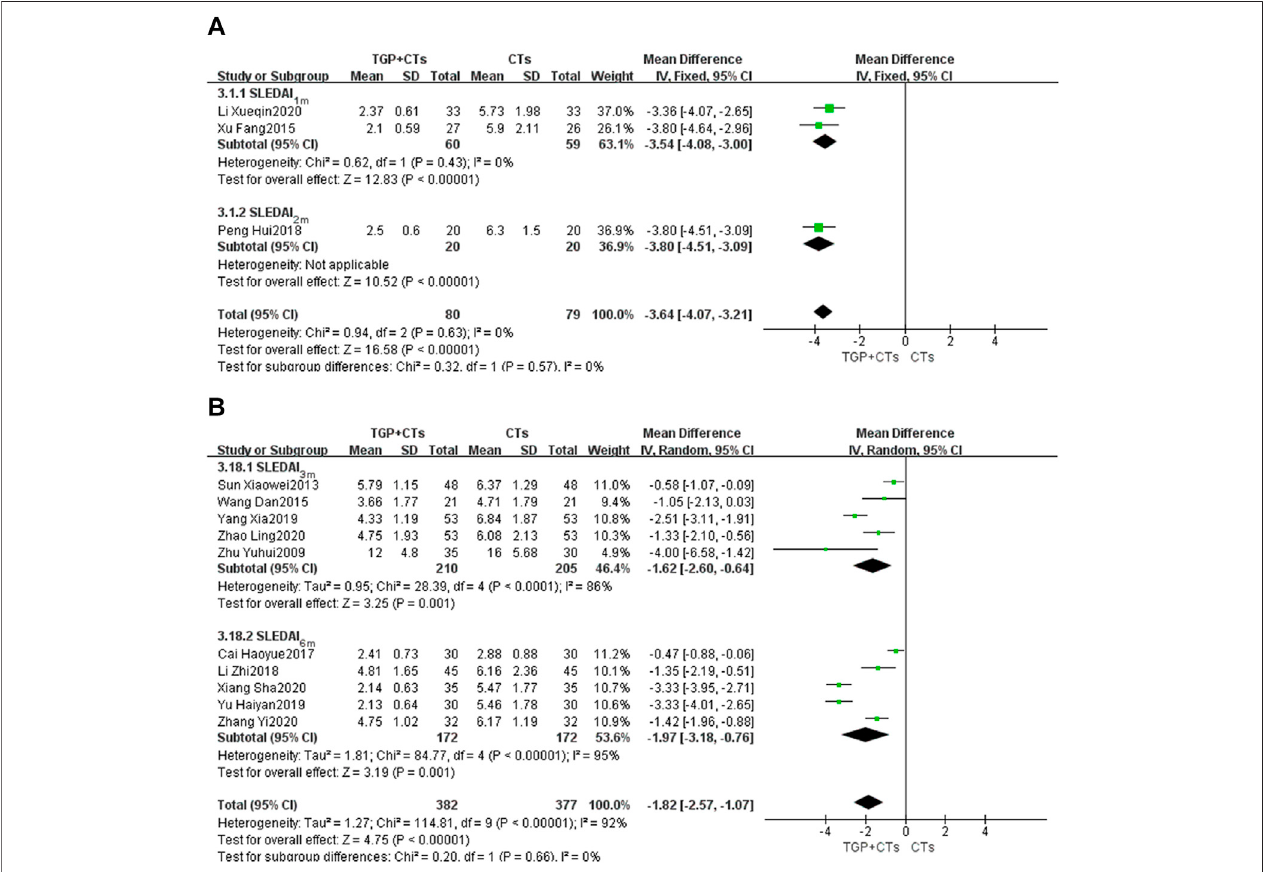
FIGURE 4 | Forest plot of SLEDAI score at 1 month, 2 months (A) , 3 and 6 months (B) .